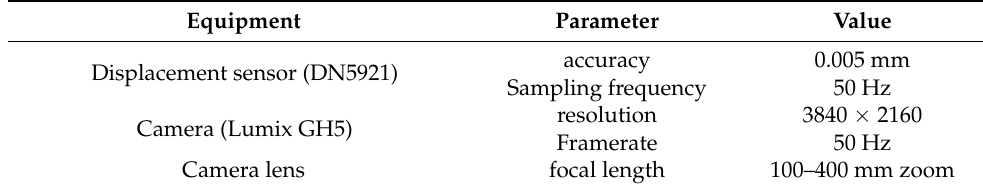
Table 1. List of hardware equipment used in the real bridge